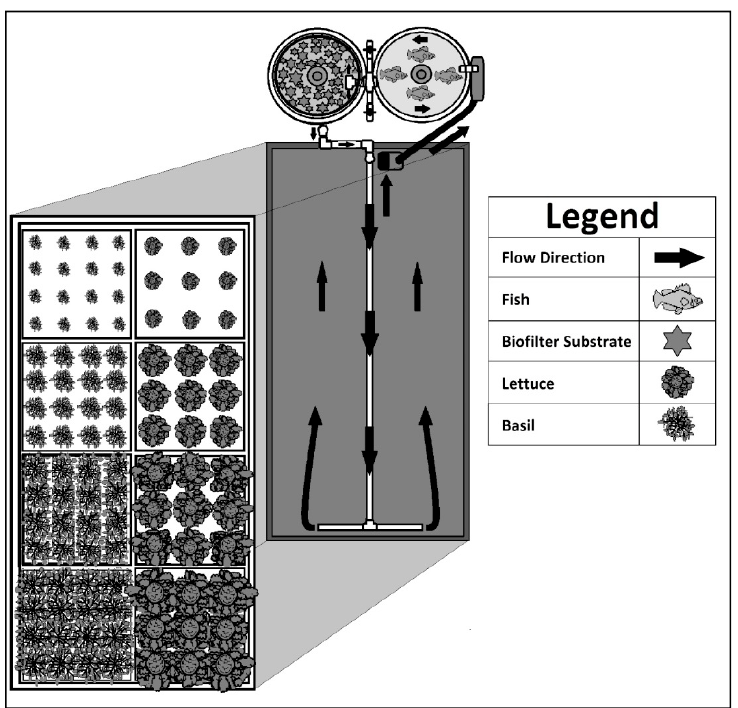
Figure 1. Overview of the total unit in the Iowa State University model aquaponic system utilized to grow lettuce, basil, and Barramundi.